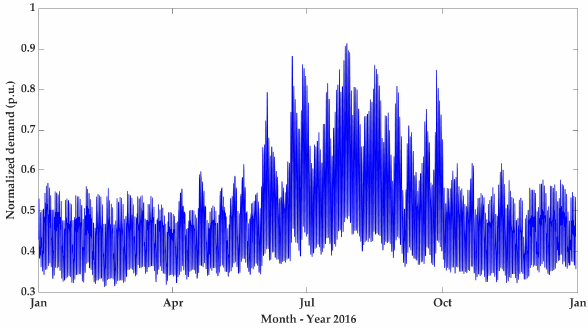
Figure 3. 2016 demand profile (normalized)